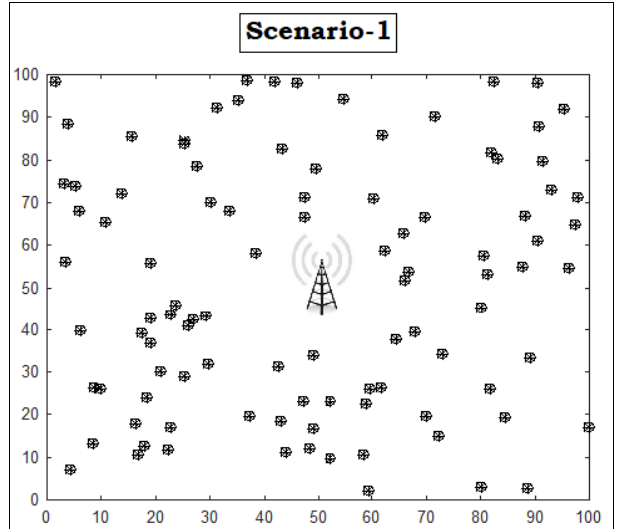
Figure 1. Network Layout-Scenario-1